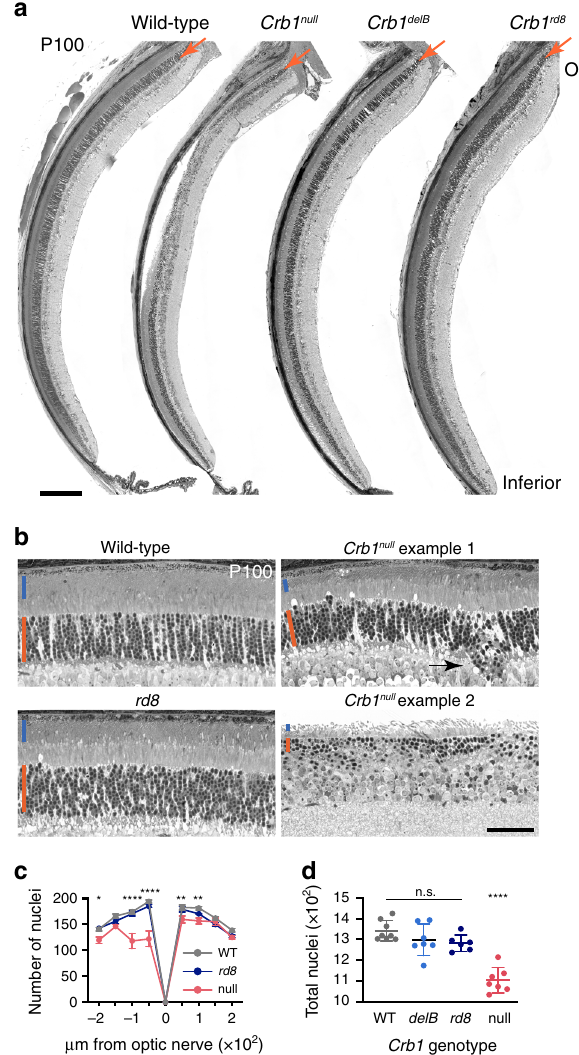
Fig. 10 Ablation of all Crb1 isoforms causes retinal degeneration. a Retinal histology in Crb1 mutant mice at P100. Thin plastic sections through inferior hemisphere are shown for homozygous mutants of indicated genotype, and wild-type controls. Arrow, ONL layer containing photoreceptor nuclei. A particularly severely affected Crb1 null retina is shown; note large focal region of photoreceptor loss accompanied by retinal detachment. Areas outside the most aggressively degenerative patch show ONL thinning. Crb1 delB and Crb1 rd8 mutants show no apparent loss of ONL cells. ONH, optic nerve head. b Higher magni fi cation views of retinal histology, 450 μ m inferior to ONH. Images from two different Crb1 null animals are shown to highlight variability in focal degeneration. Even the mild null case has thinner ONL (orange line) with fewer nuclei than age-matched Crb1 rd8 . Outer segment length (blue line) is also diminished in null mutants. c , d Quanti fi cation of ONL cell number at P100. Spider plot ( c ) shows counts of ONL nuclei in 100 μ m bins distributed uniformly across retinal sections (e.g., a ). Left, inferior side. For Crb1 delB spider plot see Supplementary Fig. 7. d Total ONL nuclei counted in all 8 bins. Statistics ( c ): two-way ANOVA with Sidak post- hoc test. P values refer to WT vs. null comparison; rd8 was not signi fi cantly different from WT at any location. * P = 0.015; ** P = 0.007, P =